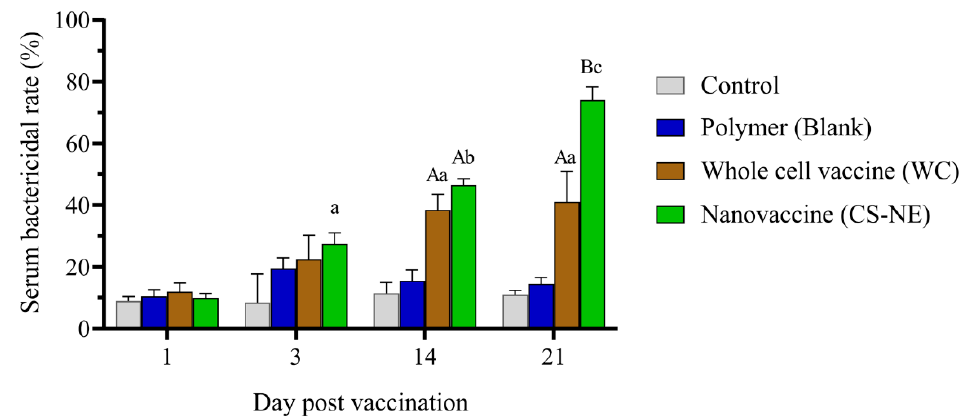
Figure 5. Serum bactericidal activity (SBA) of vaccinated fish . SBA of sera from CS-NE vaccinated were significantly higher than control groups at 1, 3, 14, and 21 days post-vaccination . Different capital letters indicate significant differences between groups at p < 0 . 05 within each time point. Different small letters indicate significant differences over time within each group (N = 6) . Two-way analysis of variance, and repeated measures analysis of variance followed by Bonferroni’s multiple comparison test were used for statistical analysis .